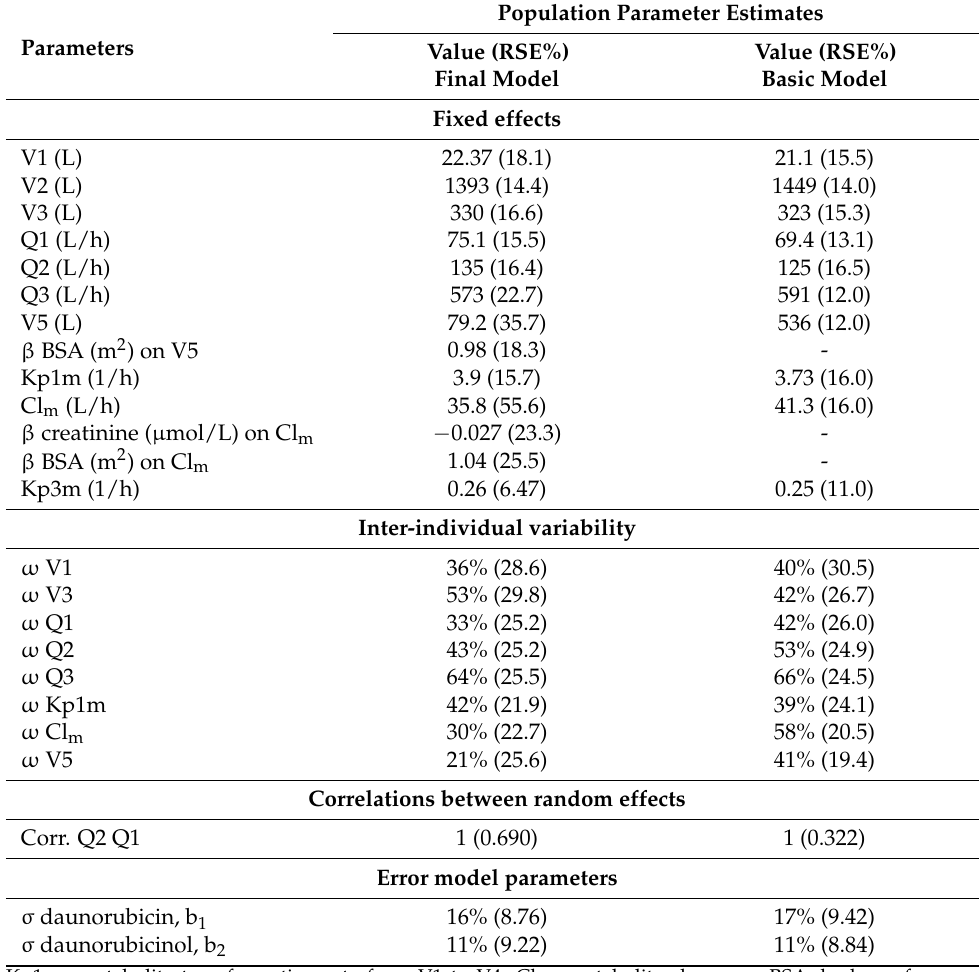
Table 2. Population pharmacokinetic parameter estimates for the basic and final